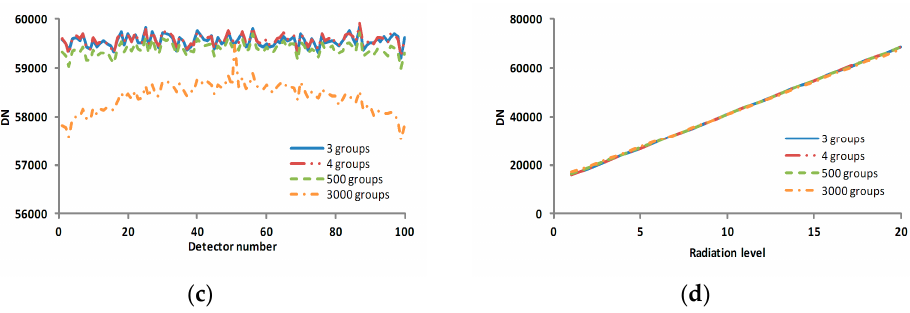
Figure 16. The profiles of the calibration coefficients and corrected results in the various scenarios of Case 3. ( a ) the gain coefficient in various scenarios; ( b ) the offset coefficient in various scenarios; ( c ) the profile of line 20 in the corrected result corresponding to Figure 15; and ( d ) the profile of column 50 in the corrected result corresponding to Figure 15. The horizontal axes of ( a – c ) are the pixel number, and the vertical axes of ( a – c ) are gain coefficient, offset coefficient and DN, respectively. The horizontal axis and vertical axis of ( d ) are radiation level and DN, respectively.